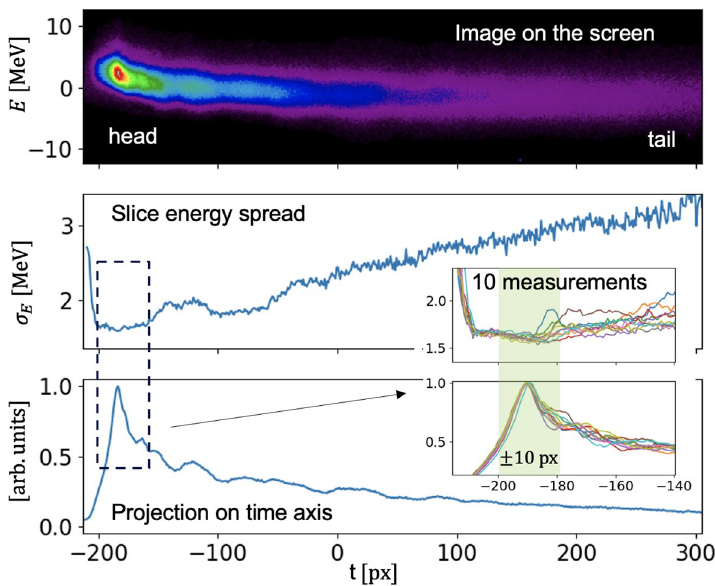
Figure 2. The beam slice energy spread measurements with the corrugated structure for the open undulator case. Zero on the time axis corresponds to the center of mass of the image.